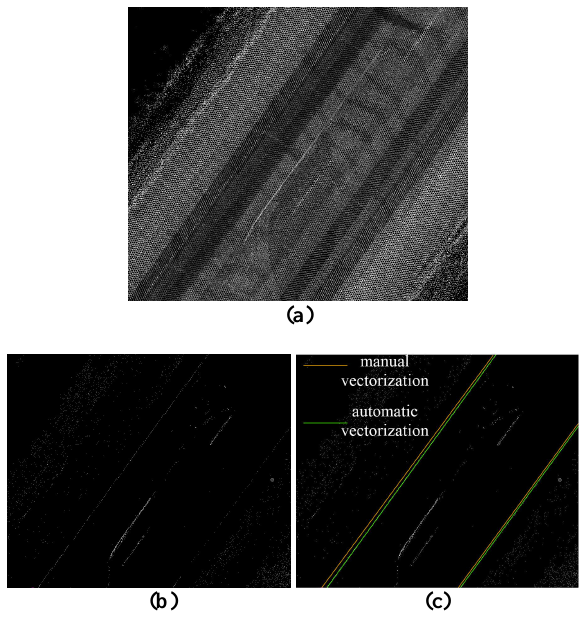
Figure 7 . The process of extracting road edges: ( а ) top view of the point cloud; (b) the result of extracting points by intensity; (c) the process of extracting road edges. Figure 6 . The result of topographic plan production at the place of a building location.